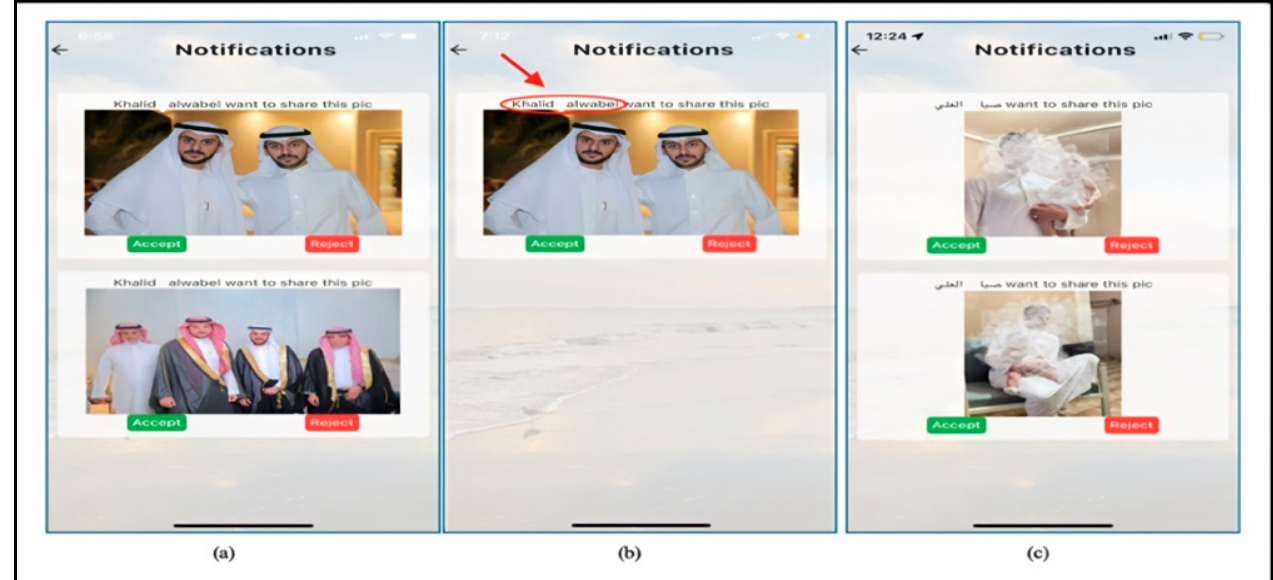
Figure A2. Screenshots of the Feature of The Proposed Methodology in application: ( a ) represents everybody in the image receive a notification, ( b ) represents the publisher name and ( c ) represents even account holder will receive a notification if he/she publish photo for here self we consider case of children play with pedant devices.